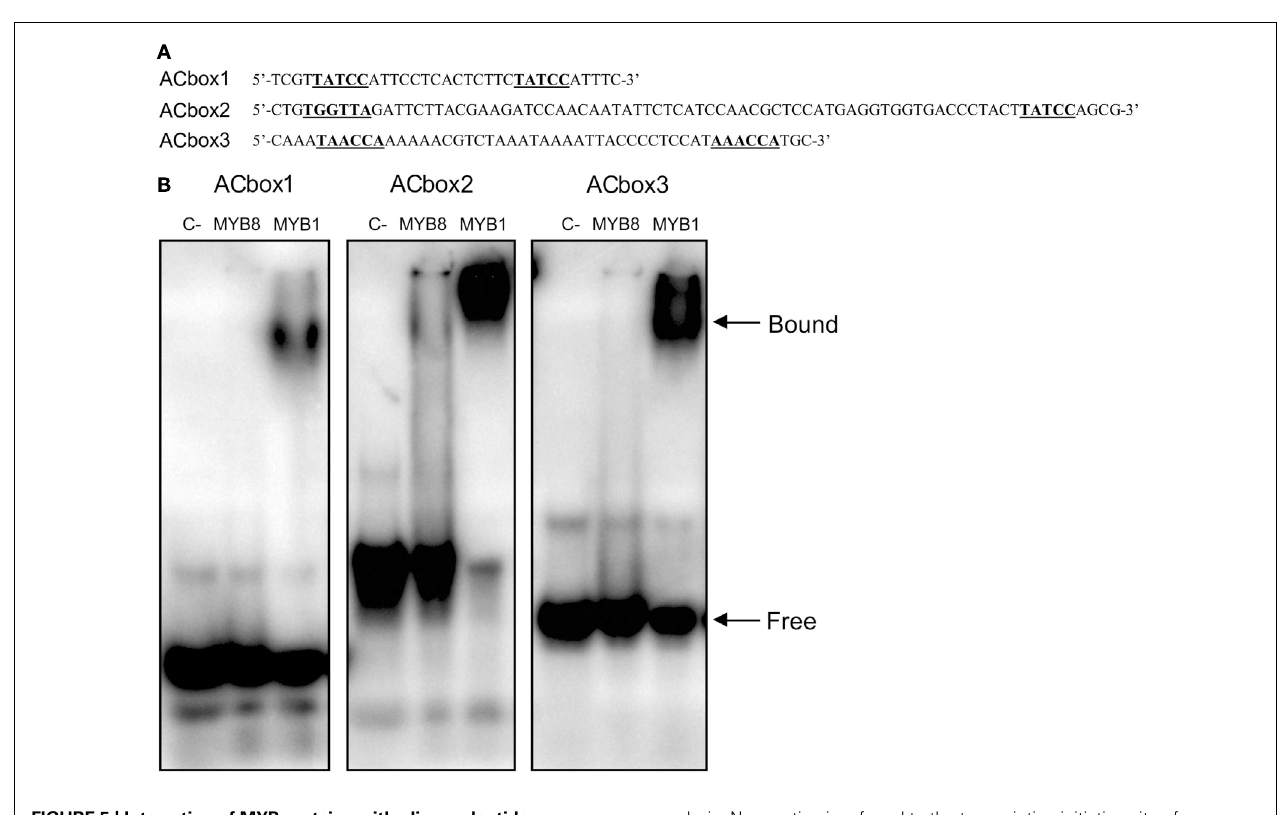
FIGURE 5 | Interaction of MYB proteins with oligonucleotide probes derived from the PpAS1 promoter. (A) The sequence of three oligonucleotides containing the MYB binding motif predicted within the PpAS1 promoter and used as probes for the EMSA